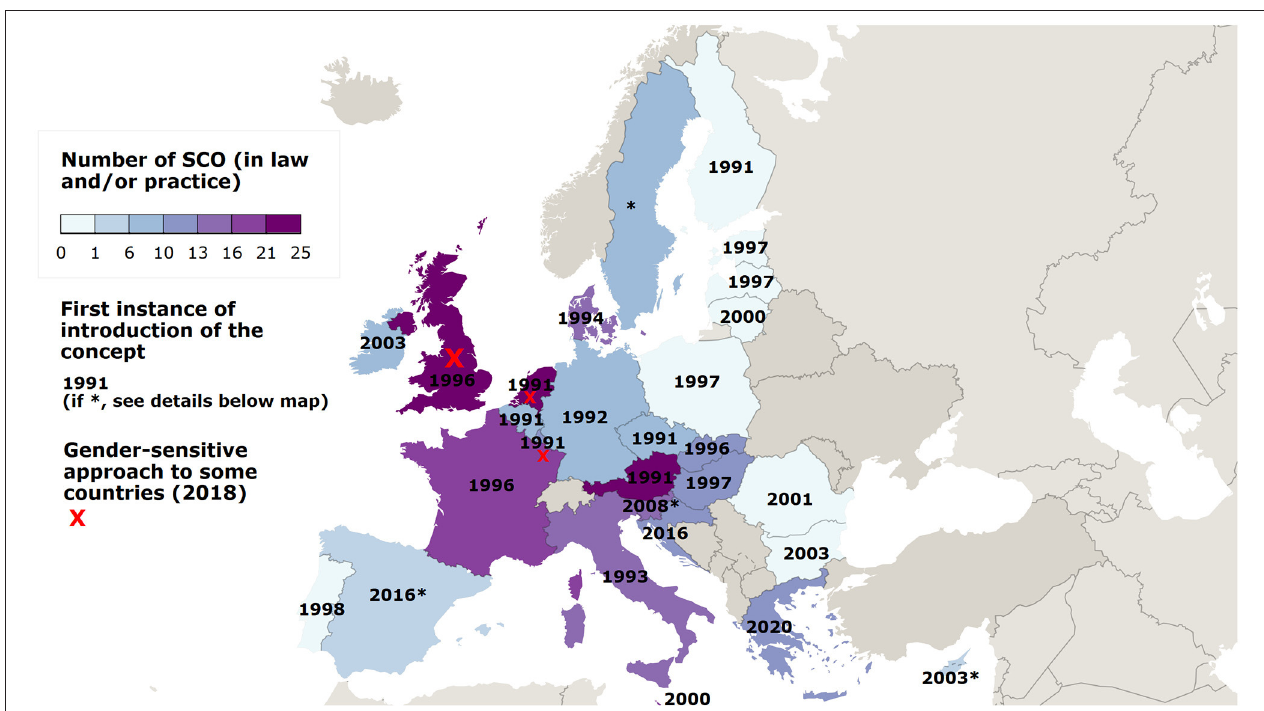
FIGURE 1 | “Safe Country of Origin” Practices in the EU in 2020. Basemap from GISCO—Eurostat (European Commission)—Author’s compilation based on AIDA (2020) , European Migration Network (2018), and Engelmann (2014). For sake of consistency, EU, EEA, Schengen States, Monaco, Andorra, San Marino, and Vatican City were excluded from the count when they were explicitly stated in lists, since they are de facto considered as safe by all EU member-states. Please see the footnote for details on the countries marked by an asterisk 8 Made with